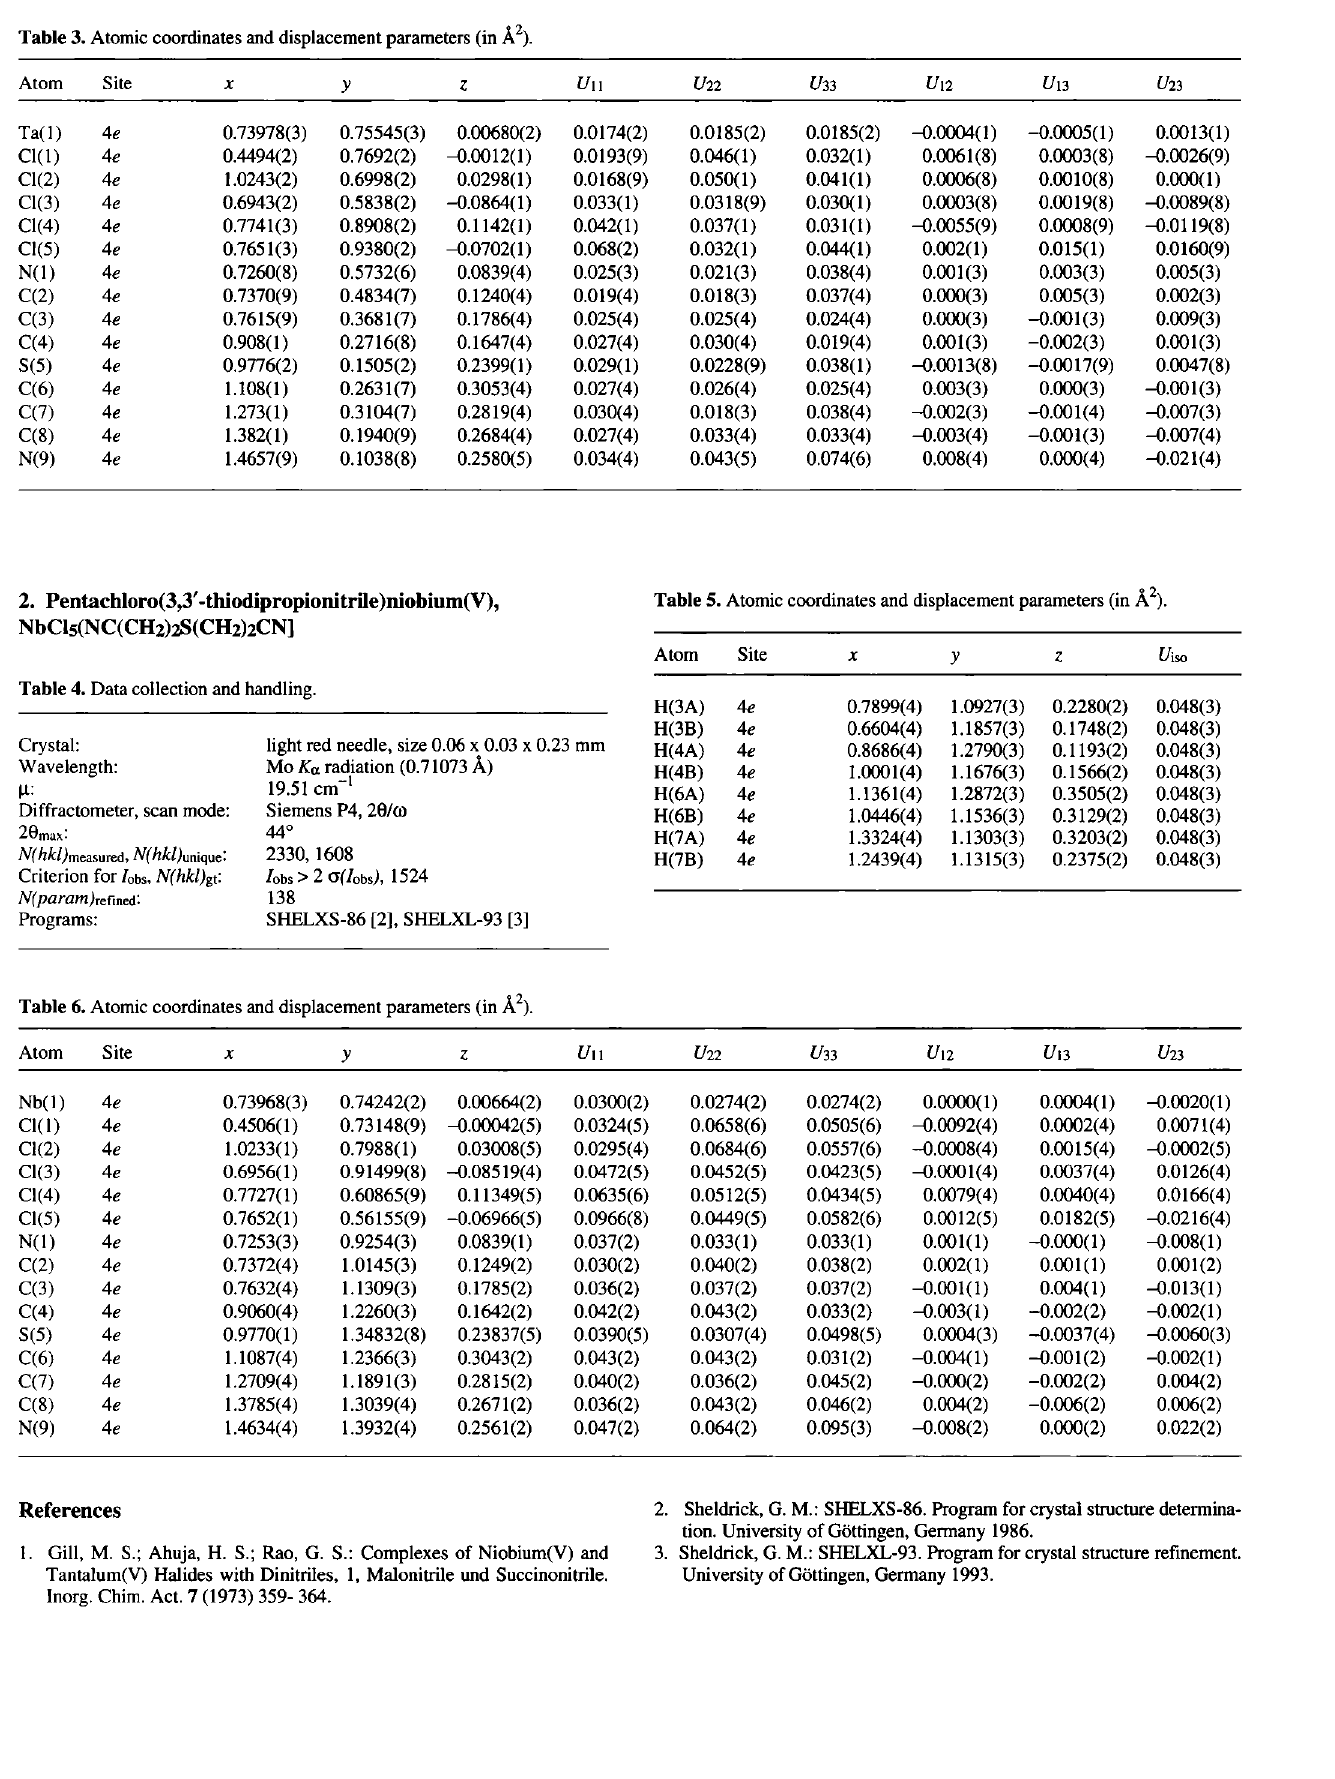
Table 5. Atomic coordinates and displacement parameters (in Â 2 ).